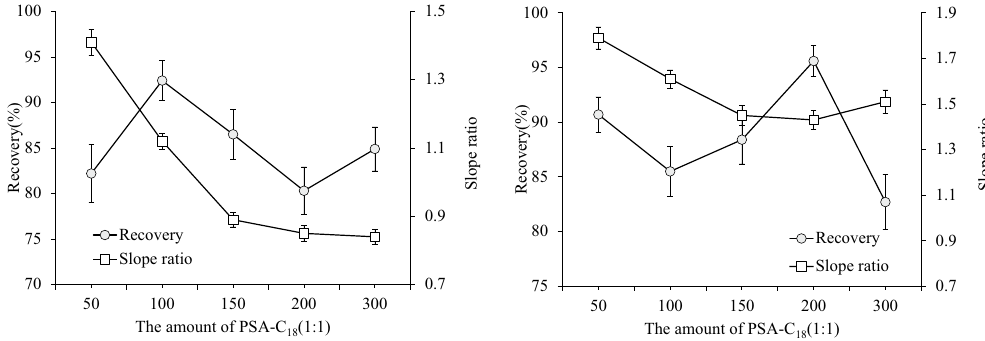
Figure 3. Effect of different amounts of PSA-C 18 (1:1) on the recovery of fenaminosulf ( a ) and iprodione ( b ) and ratios of the external calibration slopes for the matrix-matched standards to the external calibration slopes for the standards in solvent. (Mean ± SD).